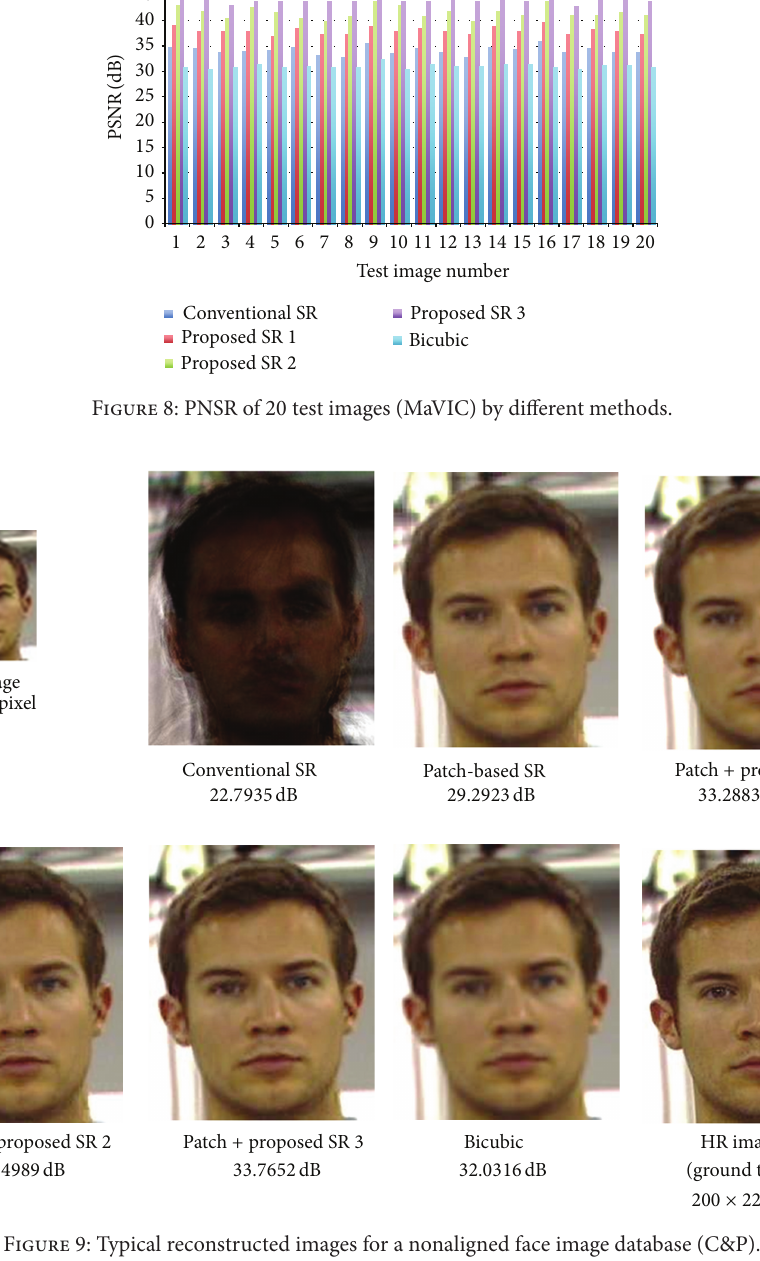
Figure 9: Typical reconstructed images for a nonaligned face image database (C&P).